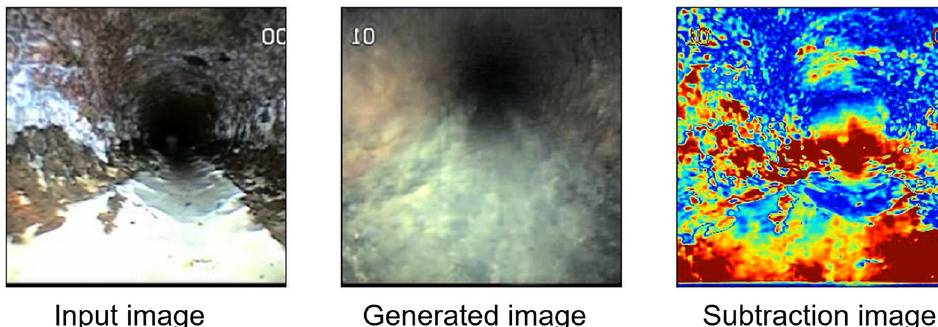
Fig. 13 Experimental results of rust anormaly cast iron pipe (GAN)